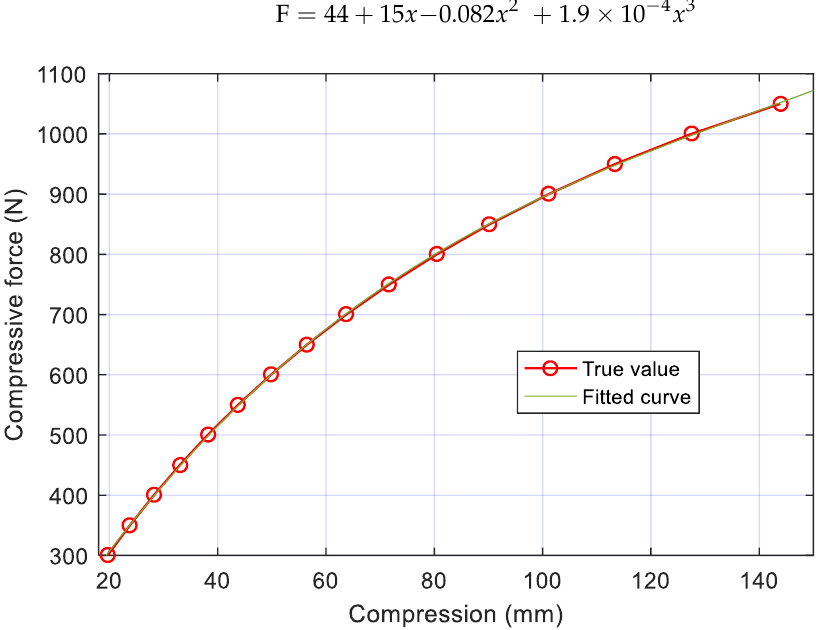
Figure 3. Leg length change under different compressive forces, Ep = 197 GPa, Eq = 197 GPa, initial length = 800.9 mm.